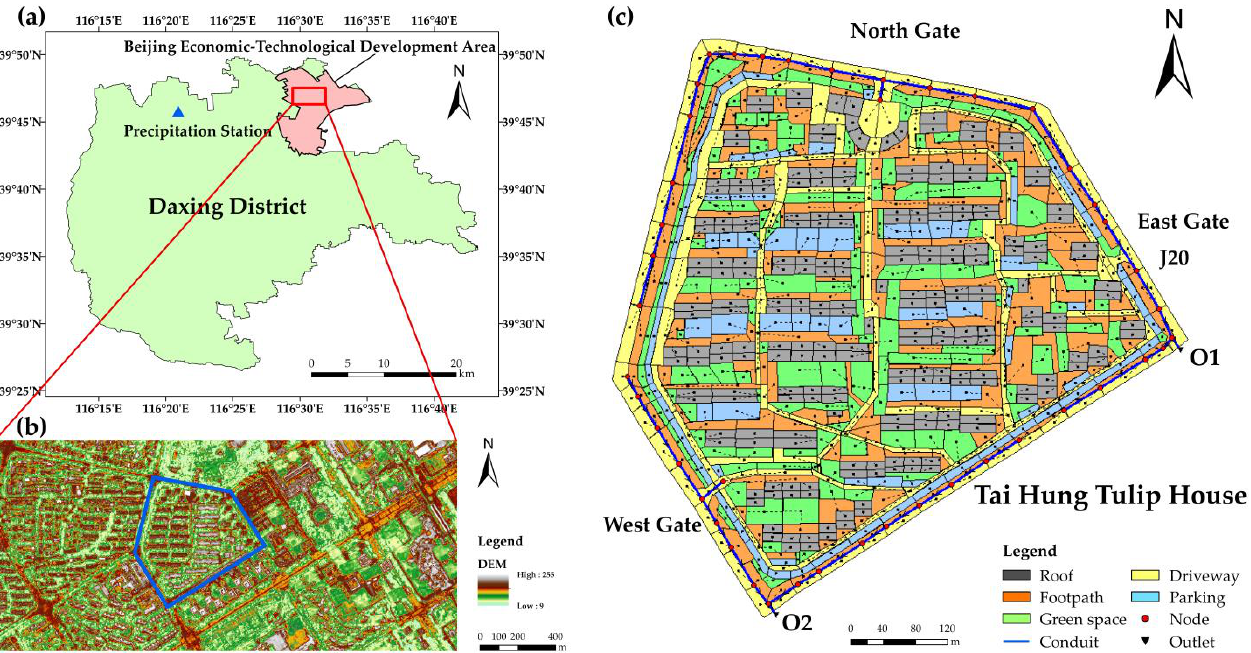
Figure 1. Study area position and Tai Hung Tulip House (THTH) community catchment as used in the model. ( a ) Location of Beijing Economic-Technological Development Area; ( b ) digital elevation model of THTH community; ( c ) land use and drainage networks of THTH community.